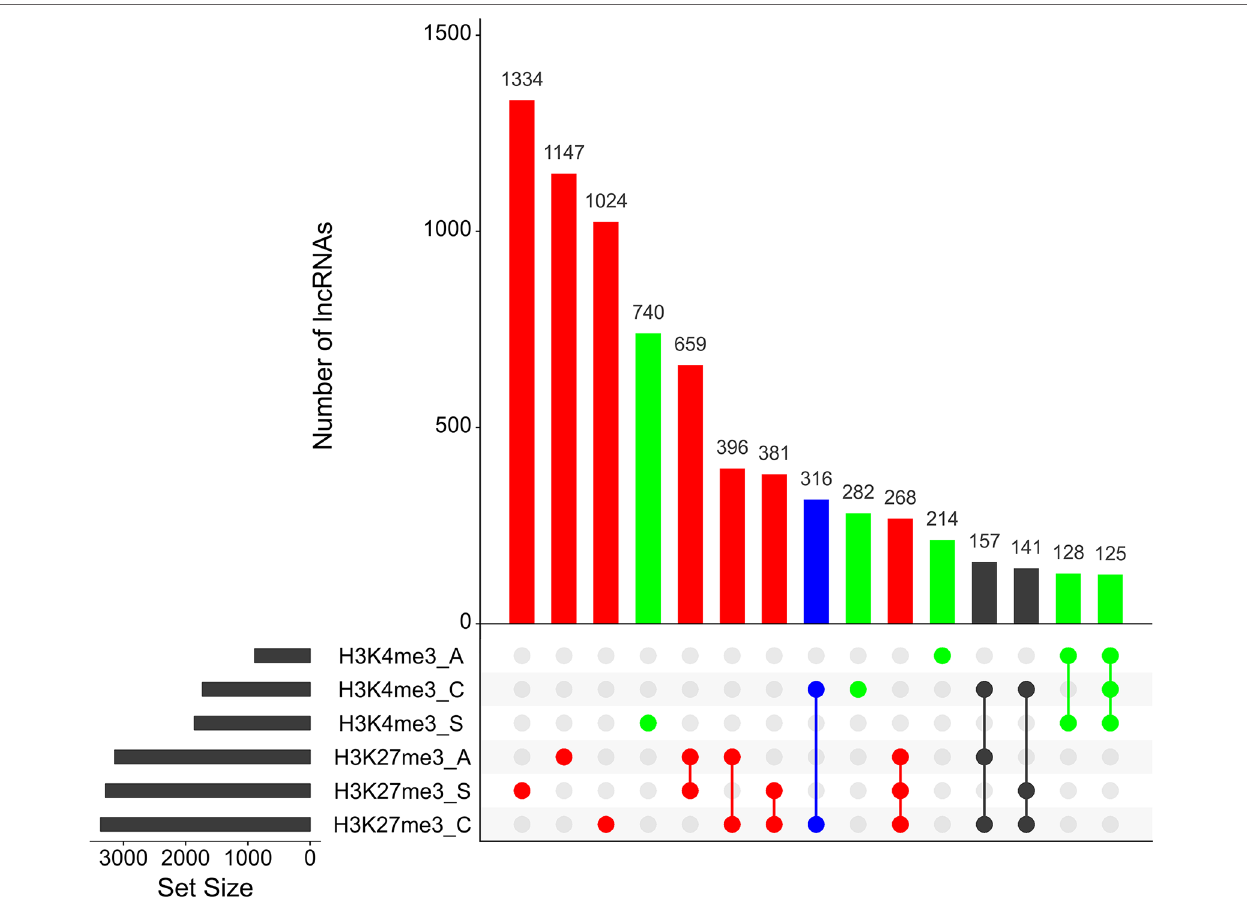
FIGURE 5 | Hundreds of S. mansoni lncRNAs have histone transcriptional activating or repressive marks at their TSS exclusively in one life-cycle stage. The UpSet intersection diagram shows the number of S. mansoni lncRNAs (y-axis) that have been detected in each of the intersection sets, indicated by the connected points in the lower part of the plot, as having the H3K4me3 transcriptional activating marks (green) and/or the H3K27me3 repressive marks (red) within 1 kb (upstream or downstream) from their TSS. Six histone mark data sets indicated at the bottom left were analyzed: H3K4me3_A in adults, H3K4me3_C in cercariae, H3K4me3_S in schistosomula, H3K27me3_A in adults, H3K27me3_S in schistosomula, and H3K27me3_C in cercariae, and each set size black bar represents the number of lncRNAs that contain the indicated histone mark at the indicated stage. The top 15 most enriched intersection sets are shown; all intersection sets and the lists of lncRNAs in each intersection set are shown in Supplementary Table S5 . The intersection set in blue shows the number of lncRNAs with the simultaneous H3K4me3_C/H3K27me3_C marks at their TSS in cercariae, characteristic of poised